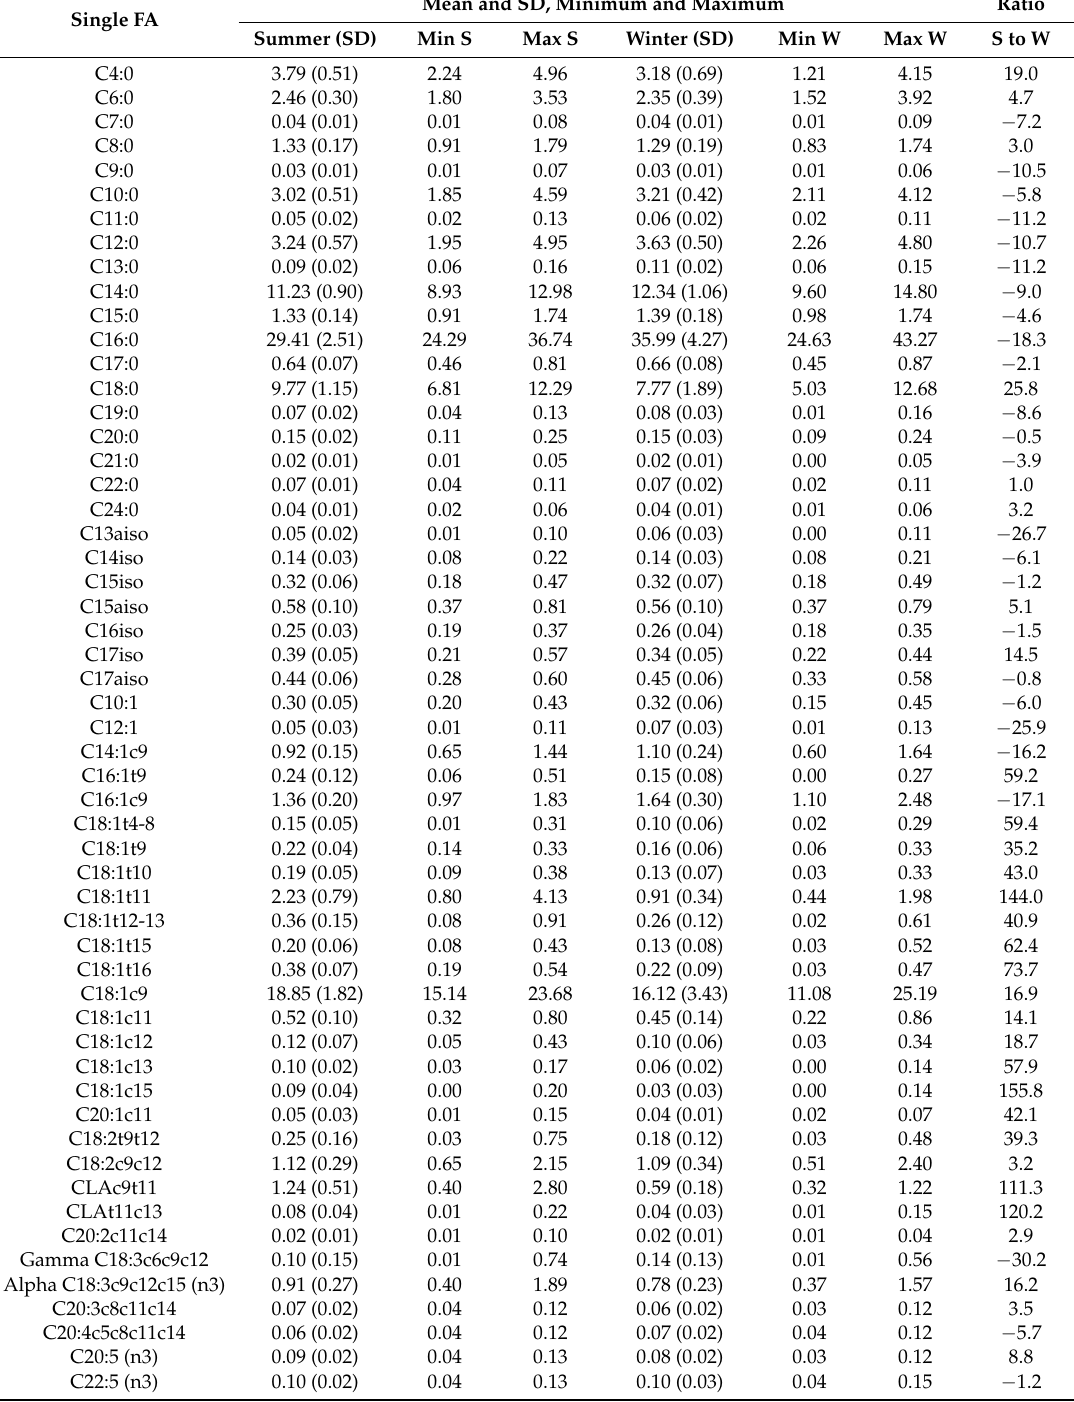
Table 3. Single (above) and sum (below) fatty acid (FA) from the biodynamic summer (left) and winter (right) milk samples. Mean value, standard deviation (SD), minimum (Min), and maximum (Max), as well as the ratio from summer to winter (S-W)/Wx100; Samples: N =